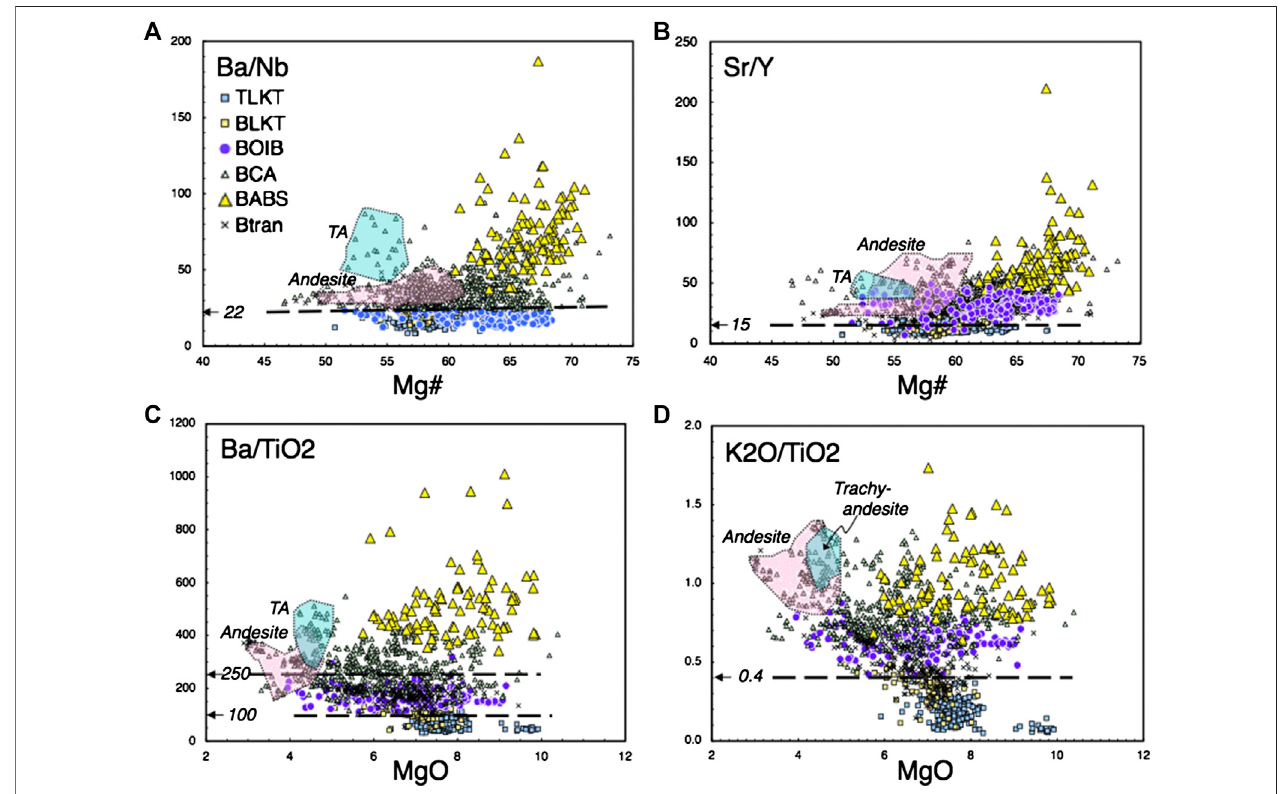
FIGURE 7 | Additionaldiscriminantdiagramsfor BVFlavas;samekey asin Figure6 .RatiosofBa/Nb,Sr/Y,Ba/TiO 2 , andK 2 O/TiO 2 areplotted vs.Mg#orMgOwt%. Note that all chemical types include a signi fi cant number of “ primitive ” lavas with MgO > 8 wt%. Ba/Nb clearly distinguishes all intraplate lavas (both LKT and OIB-like) from those of CA af fi nity (CA and ABS types). Primitive LKT types are easily distinguished in all of these diagrams, albeit some overstep the plotted discriminant lines as MgO contentdecreasesbelow7 wt%.PrimitiveABStypelavasareclearlystronglyenrichedinBa,Sr,andK 2 O,butenrichmentsintheseelementsdiminishasMgOcontent decreases. Dashed lines indicate discriminant values for abscissa parameters in de fi ning magma